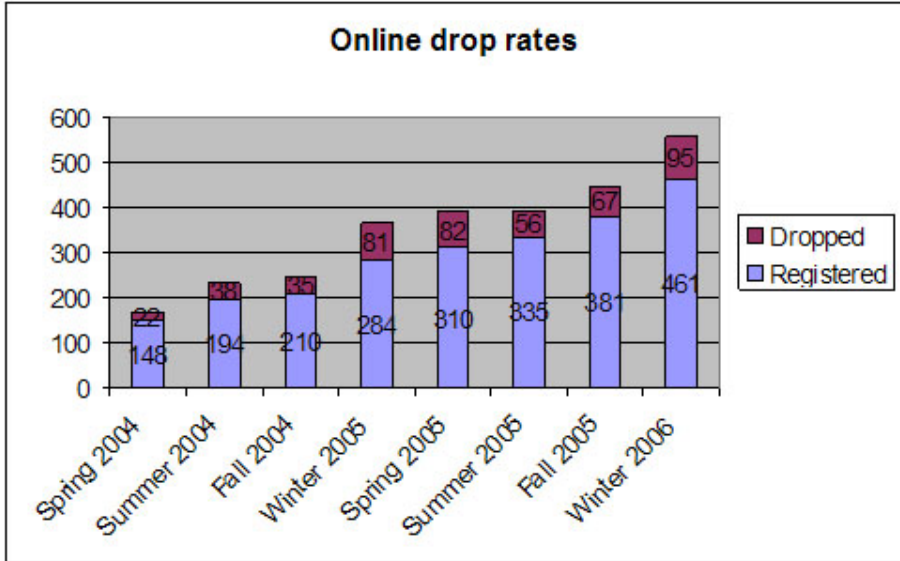
Figure 1 . Drop pattern in online courses by